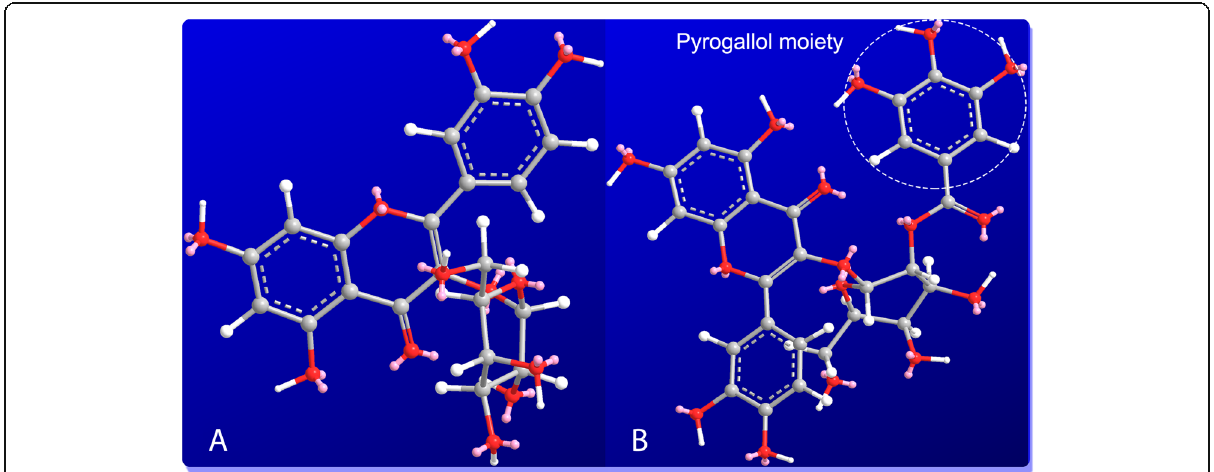
Fig. 6 The ball-stick models of hyperoside ( a ) and 2 ′′ -O-galloylhyperin ( b ) (red, O atom; white, H atom; gray, C atom; pink, long pair). The